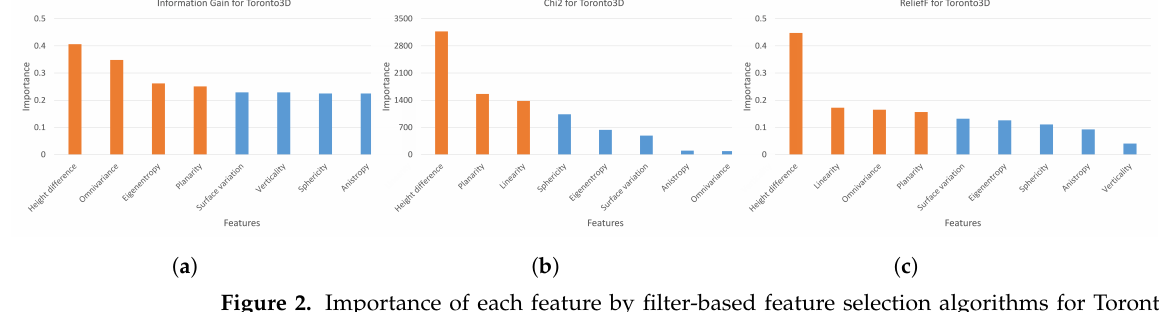
Figure 2. Importance of each feature by filter-based feature selection algorithms for Toronto3D. Selected features are marked as orange. ( a ) Feature importance calculated with IG ( b ) Feature importance calculated with Chi2. ( c ) Feature importance calculated with ReliefF.